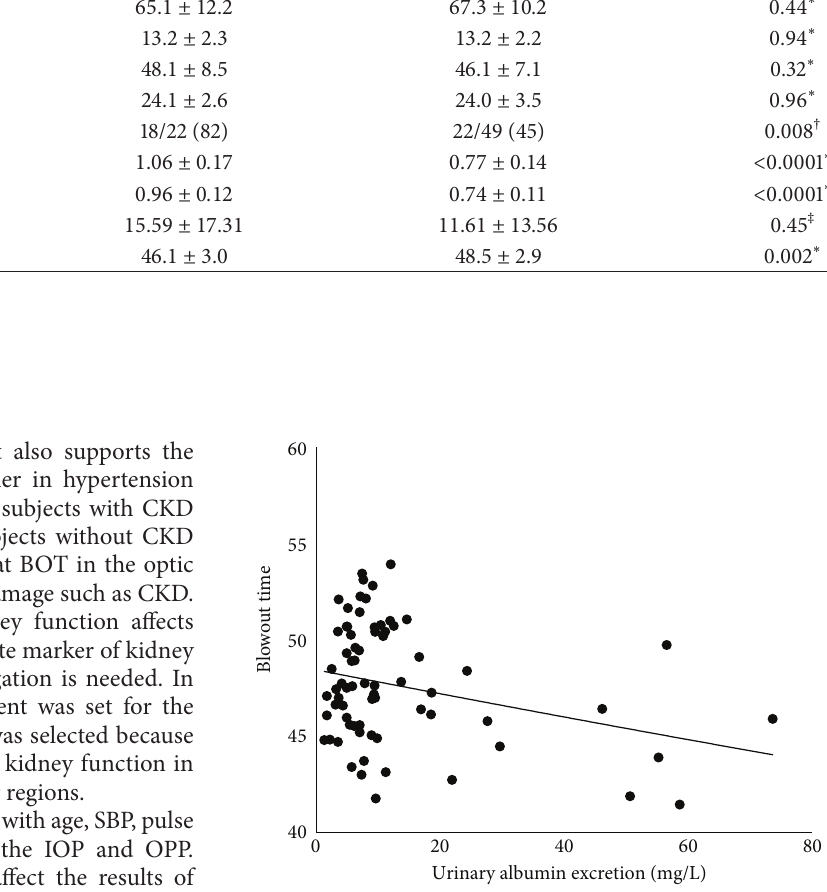
Figure 5: Correlation between blowout time and urinary albumin excretion in all